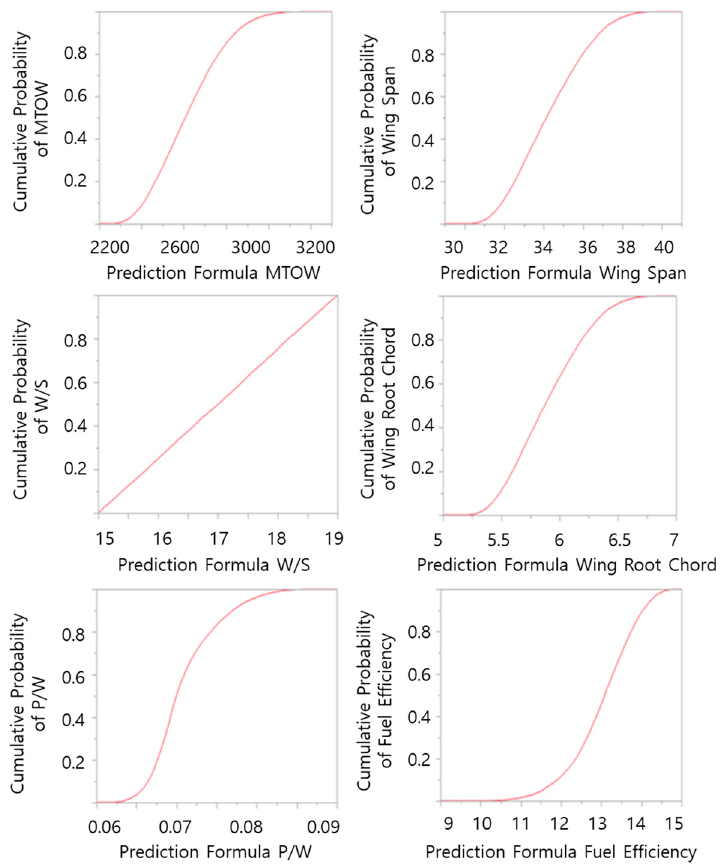
Figure 7. Feasible design space for target design variables.